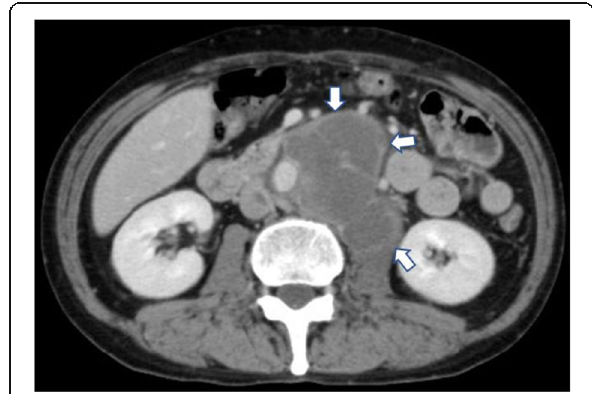
Fig. 1 Enhanced computed tomography at initial examination showing the large mass lesion along with the abdominal aorta. The margin of the mass lesion is enhanced (arrow)